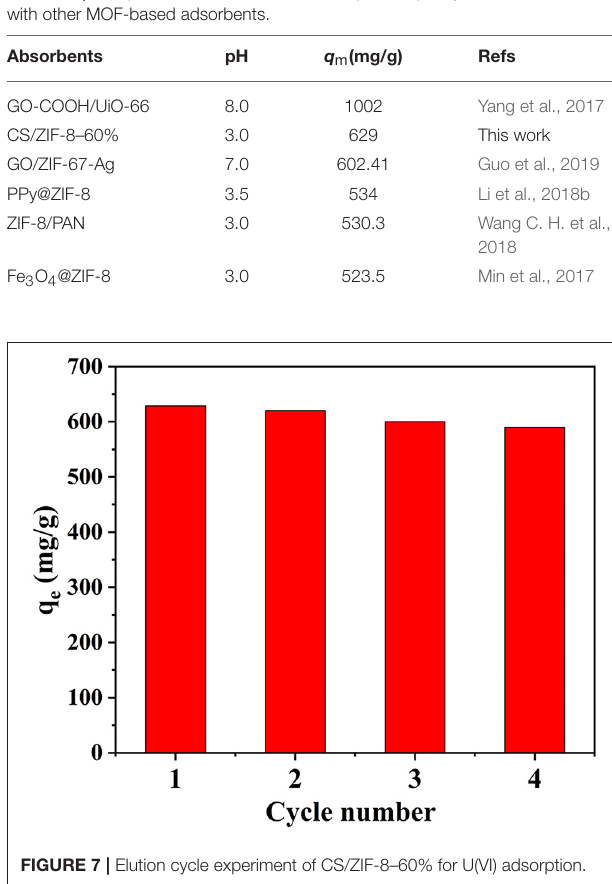
of CS/ZIF-8–60% reaches to 608 mg • g − 1 , which is